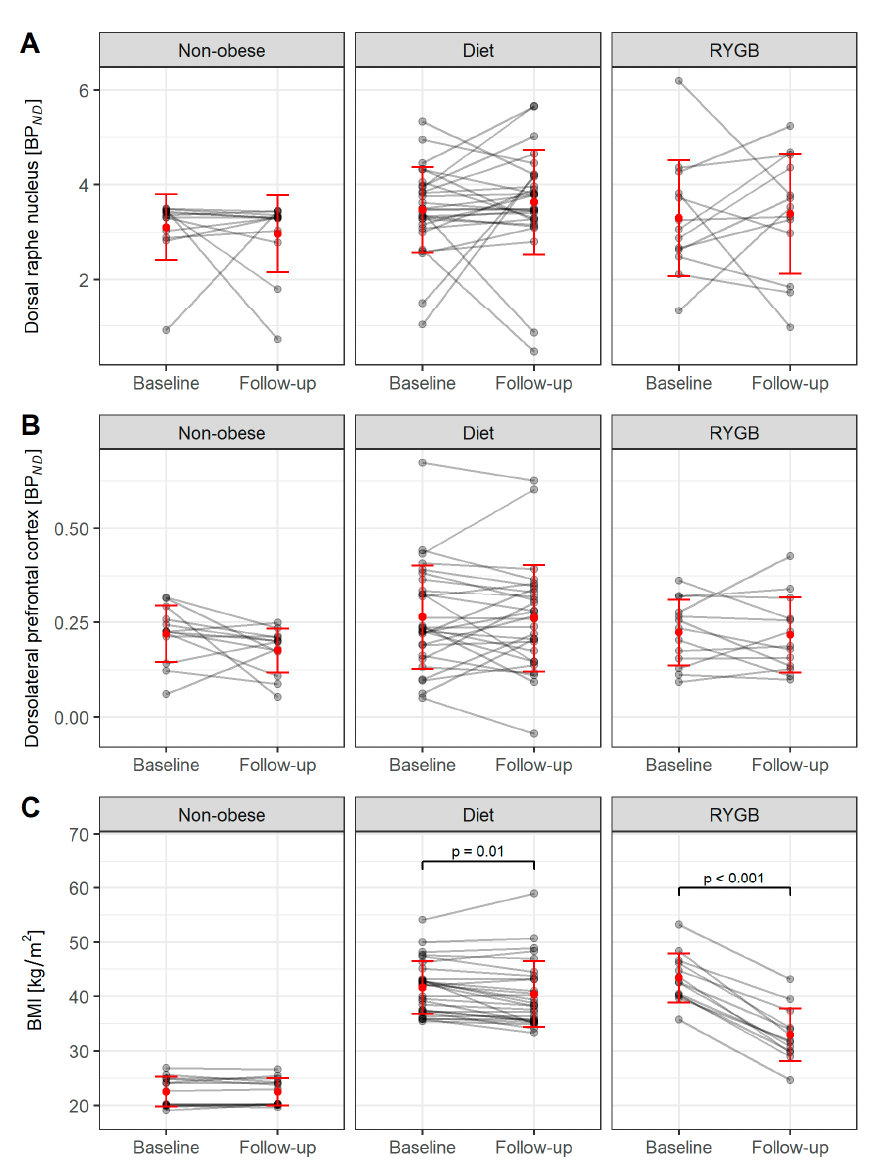
Figure 3. 5-HTT BP ND in the dorsal raphe nucleus (DRN) ( A ), in the dorsolateral prefrontal cortex (dlPFC) ( B ) and BMI values ( C ) of study participants before and after 6 months of intervention. The red dots represent the mean value and error bars indicate the standard deviation.